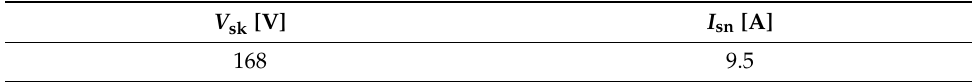
Table 2. Measurement results for the short-circuit state. V sk [V] I sn [A] 168